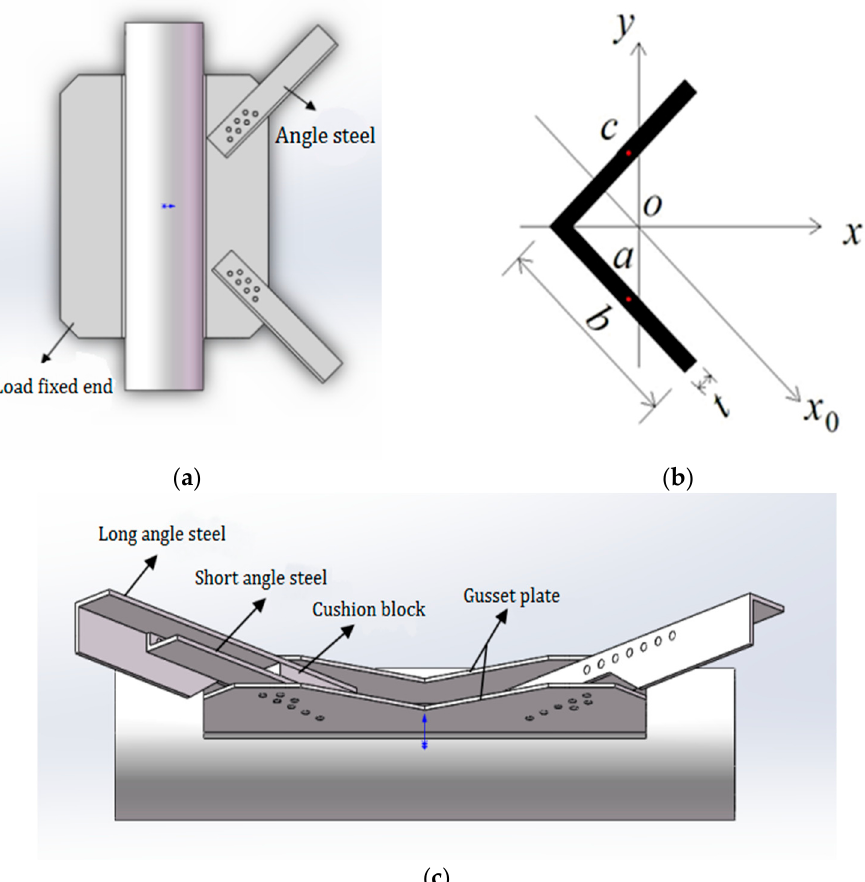
Figure 2. ( a ) Angle steel and its section characteristics of PSLSPJ; ( b ) calculation diagram of section characteristics of angle steel; ( c ) section characteristics of angle steel of PDLDPJ.